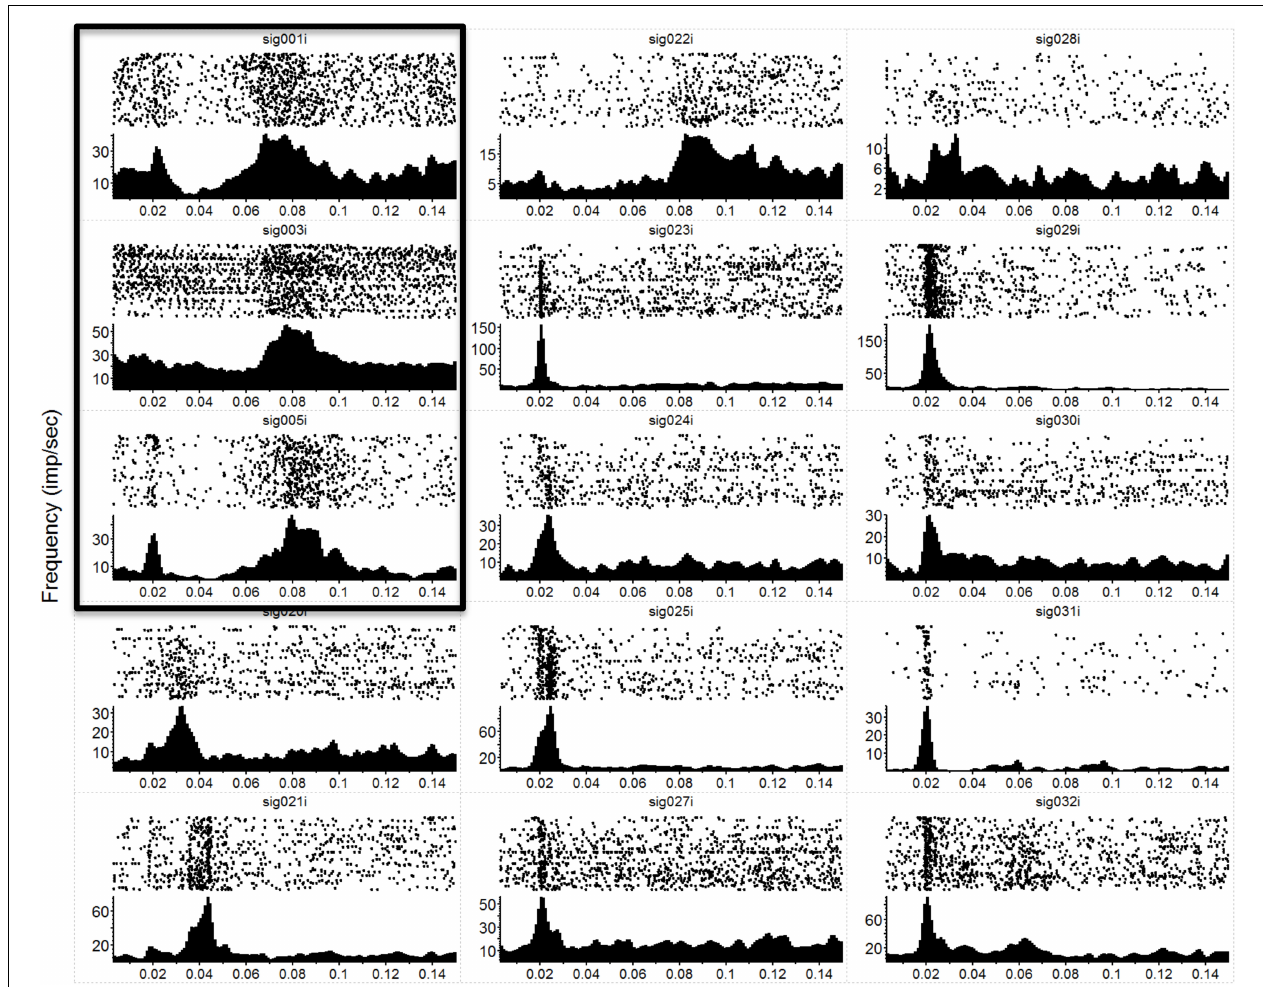
FIGURE 1 | Neural responses to mechanical stimulation. Raw data showing post-stimulus-time-rasters with their corresponding PSTHs below for a subset of the 36 recording electrodes during a single mechanical touch experiment. In this experiment, we touched the anesthetized macaque’s hand at 1 position at a frequency of 5 Hz. Each raster-histogram pair is labeled with the electrode channel number, where sig < 8 are VPL thalamic channels (first 3 panels on the left column, marked by the surrounding box) and sig > 8 are S1 cortical channels. The i indicates that these are unsorted units; thus, we are showing the multiunit activity recorded on each channel. There was a 4-electrode array in the thalamus (2 × 2, with 1 mm spacing) and a 32-channel array in the cortex (2 × 16, with an intra-row spacing of 300 µ m and inter-row distance of 1 mm). Note the diversity of responses and the differences in the y -axis, which is the unsorted units firing rate in Hz, while the x -axis is time in seconds. PSTH bins were 1 ms and smoothed with a 3 ms Gaussian moving window. The time axis starts at 3 ms to match the x -axis with Figure 2 (where MiSt stimulus artifact required blanking of the first couple of